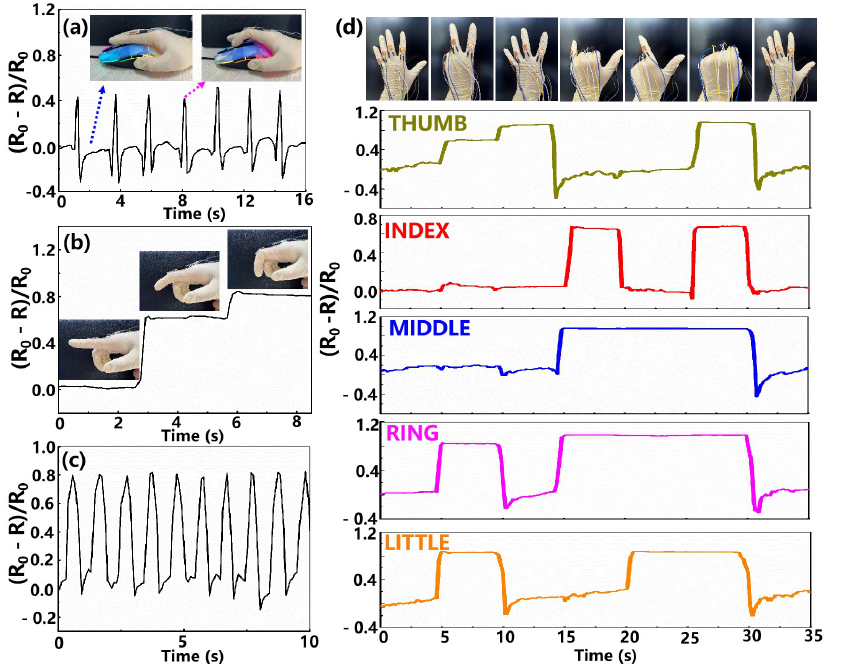
Figure 3. Monitoring of human gesture movements by the developed foam-shaped composite sensor. ( a ) The response signal of the obtained device in scrolling the mouse. ( b , c ) Detecting resistance change with an index finger ( b ) at various bending states, ( c ) and under repeated bending at the same angle. ( d ) The real-time response of the foam-like device to a sequence of Arabic numeral gestures. The application capability of the MWCNTs/Ti 3 C 2 T x MXene @ melamine foam